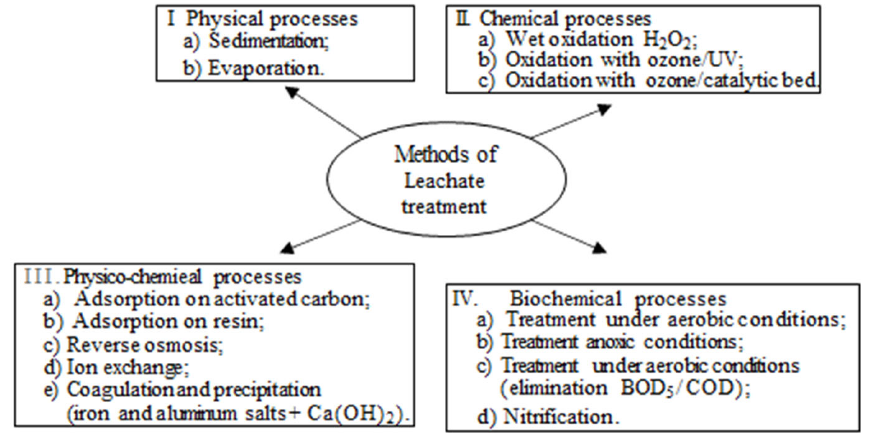
Figure 4. Techniques frequently employed at municipal landfills to treat leachate [3]. Table 3. An overview of various technologies in treating leachate. Table 4. Removal of leachate parameters by various applications performance